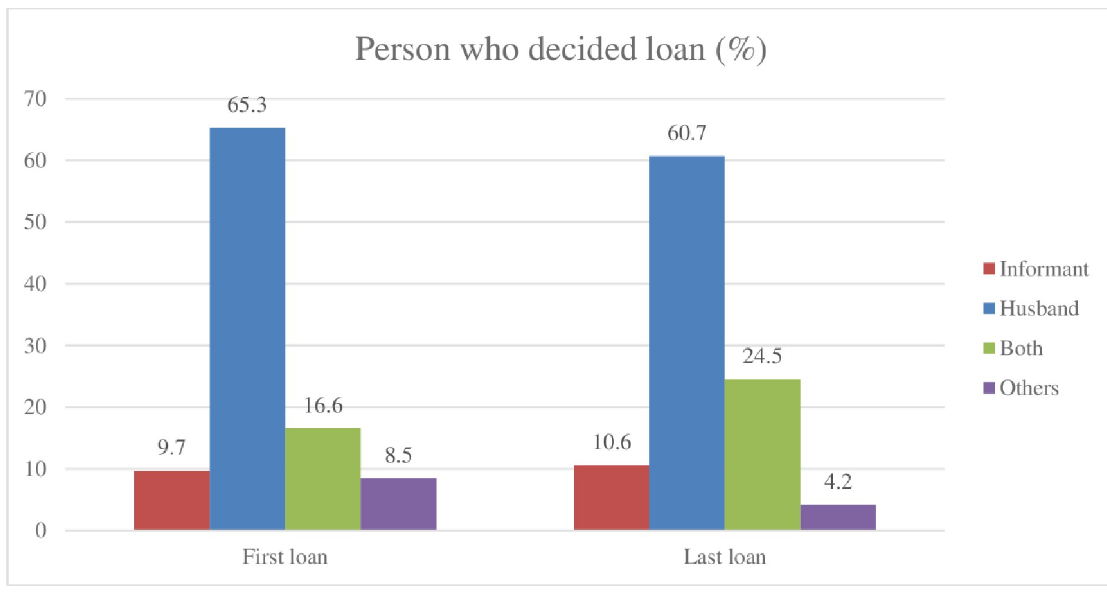
Fig 1. Loan taking